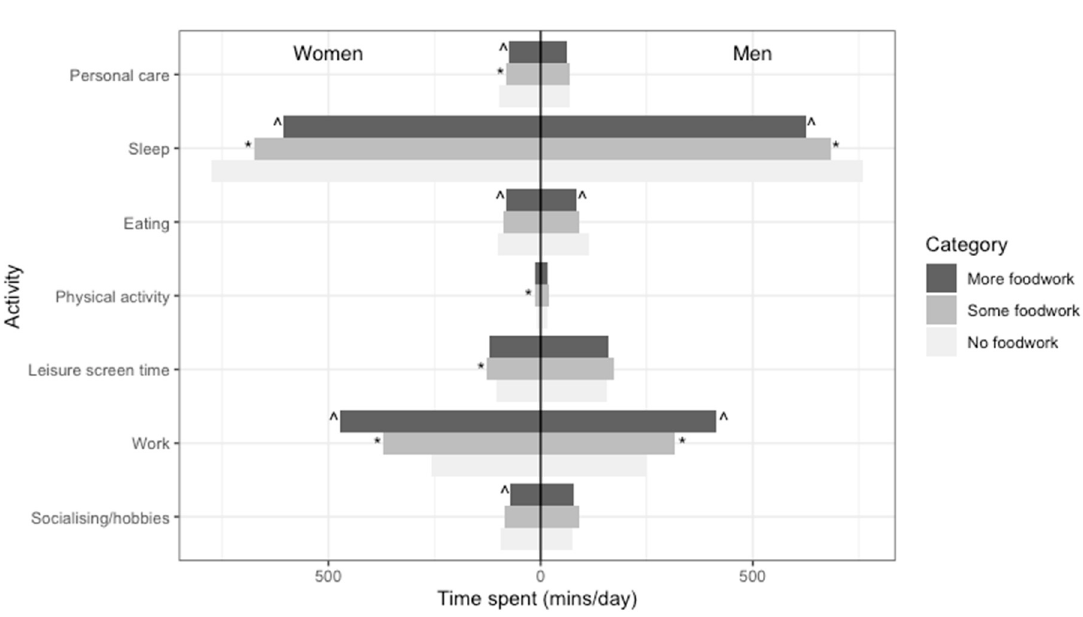
Figure 3. Model-adjusted a compositional means for economically active and inactive participants by foodwork category ( n = 6143) a Adjusted for age, gender, employment status, education, occupation, presence of children, and diary day type. ^ Statistically significant log-ratio difference between more and some foodwork for this part. * Statistically significant log-ratio difference between some and no foodwork for this part. Figure 2 shows that women who did more foodwork spent less time on personal care and socialising and hobbies, which was not the case for men. Further, while both men and women who did more foodwork spent more time on work overall, women in all foodwork categories spent more time on work. This difference was smaller, at 6 min, between men and women who did no foodwork but larger, at 61 min, between men and women who did more foodwork (see Appendix C).